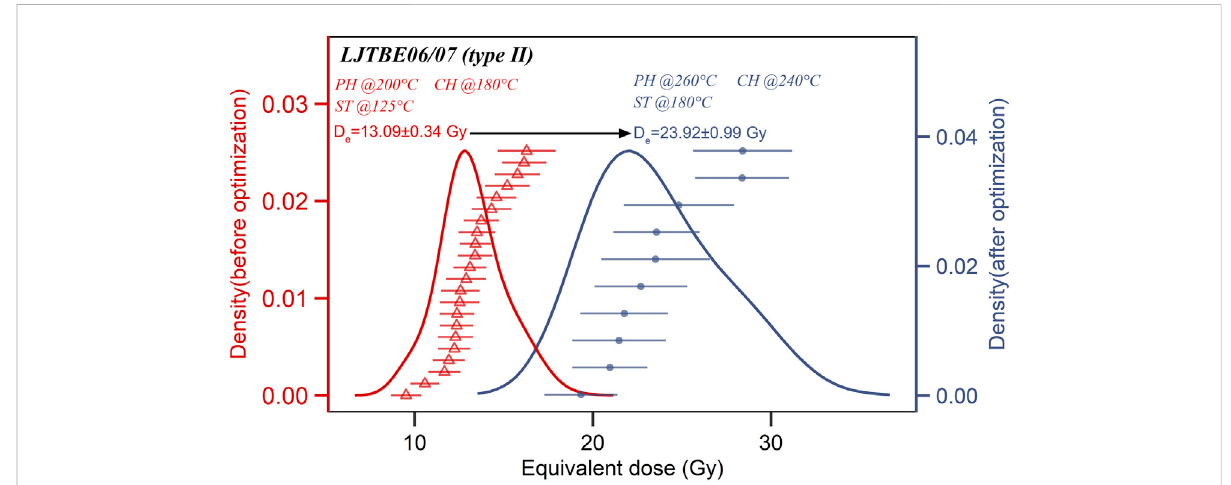
FIGURE 9 OSL-SAR D e probability density function plots of a representative type II sample ( LJTBE06/07 ) at different measurement parameters. The red line represents the underestimated probability density function plot with the measurement parameters of 200 ° C preheat, 180 ° C cut-heat and 125 ° C stimulationtemperature.Thebluelinerepresentsthemodi fi edprobabilitydensityfunctionplotwiththemeasurementparametersof260 ° Cpreheat, 240 ° C cut-heat and 180 ° C stimulation temperature. The black arrow represents the direction of modi fi cation of the CAM D e